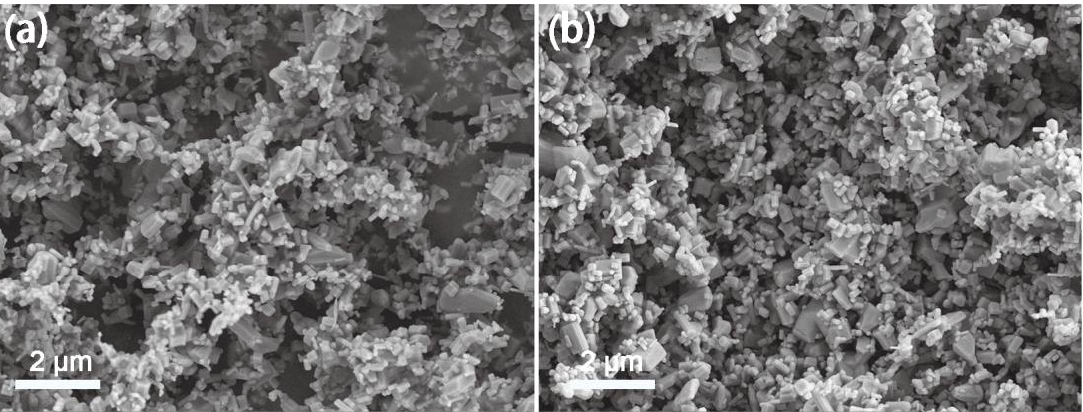
Figure 3. The SEM images of ZnO-3 powder: ( a ) As-received, and ( b ) after being magnetically stirred for five cycles.